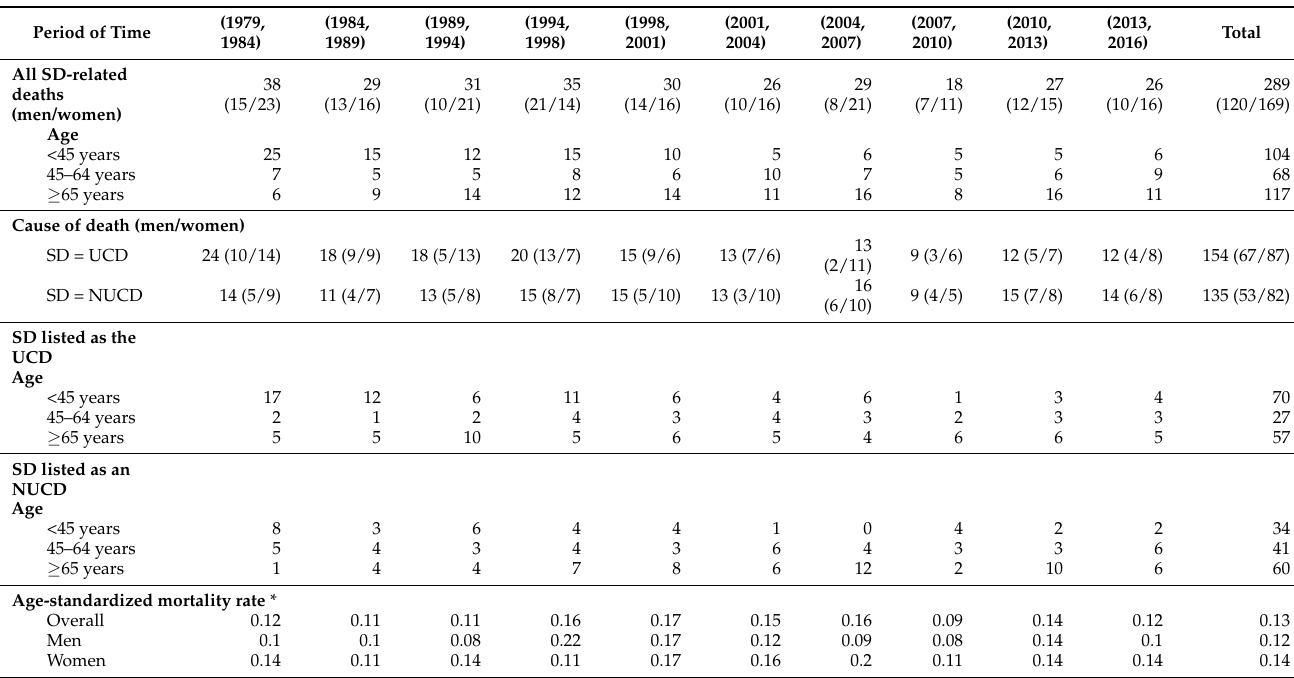
Table 1. Absolute number of deaths associated with Still’s disease in France between 1979 and 2016, and according to year